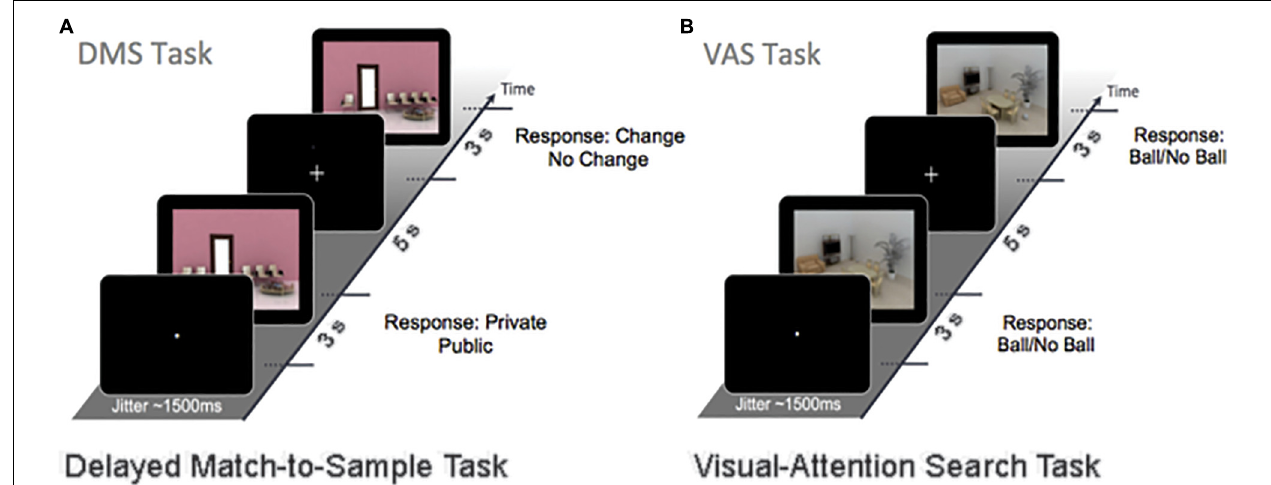
FIGURE 1 | The working-memory experimental paradigm (A) is a DMS task (120 trials). A sample stimulus (encoding) and a probe stimulus (retrieval) were presented with a stimulus delay of 5 s (maintenance). Participants were instructed to respond to whether the sample stimulus was either private or public and to memorize the image. The probe stimulus was either the same (repeat item) or had small changes in the image (lure items) that needed to be detected. (B) The VAS task (60 trials). During this task, subjects were instructed to detect whether a target (i.e., ball) was present. The background image remained the same throughout the visual-attention paradigm.